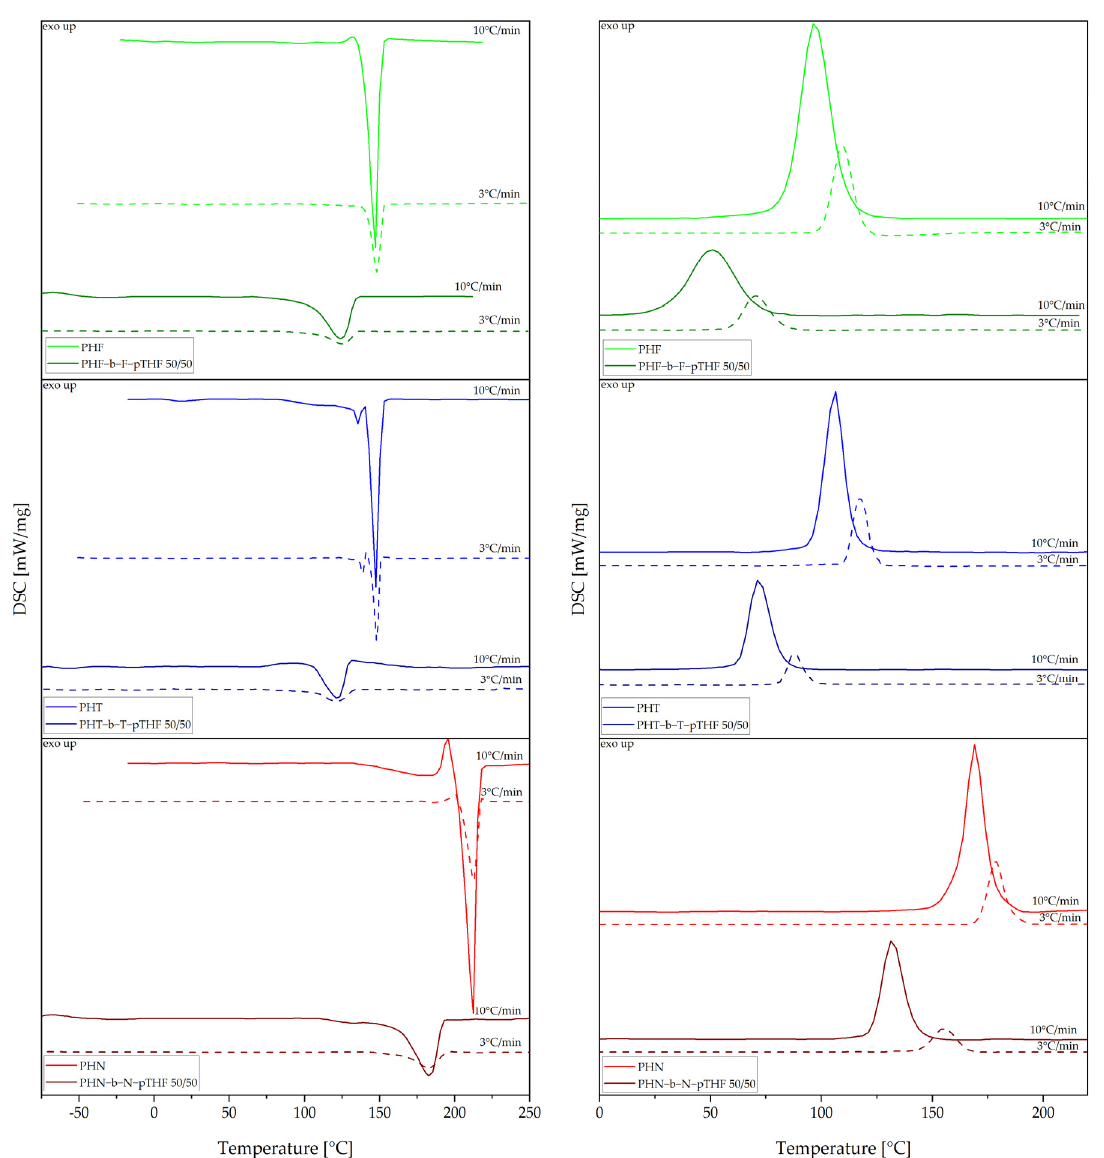
Figure 9. DSC thermograms were recorded during second heating ( left panel) and cooling ( right panel) for polyesters and copoly(ether-ester)s.